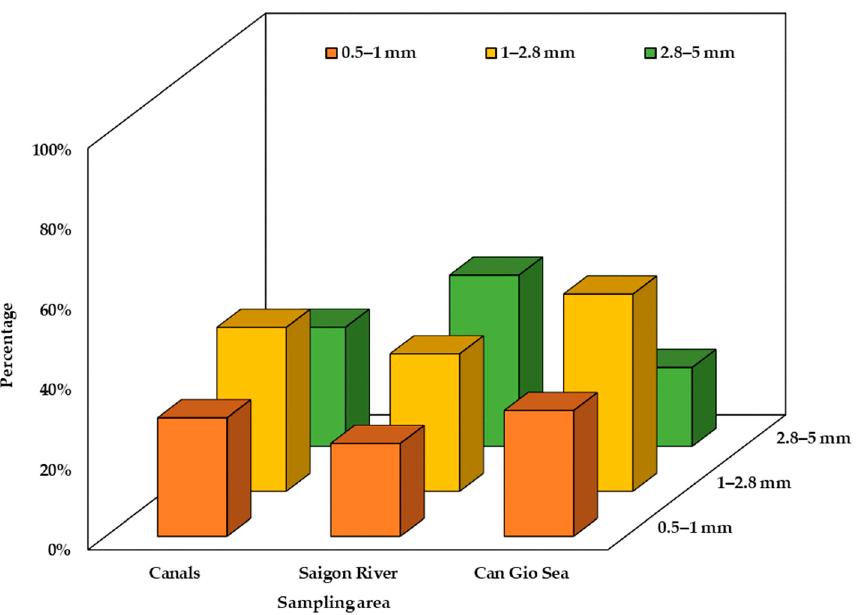
Figure 4. Size distribution of MPs in canal systems, Saigon River, and Can Gio Sea, in August 2020.